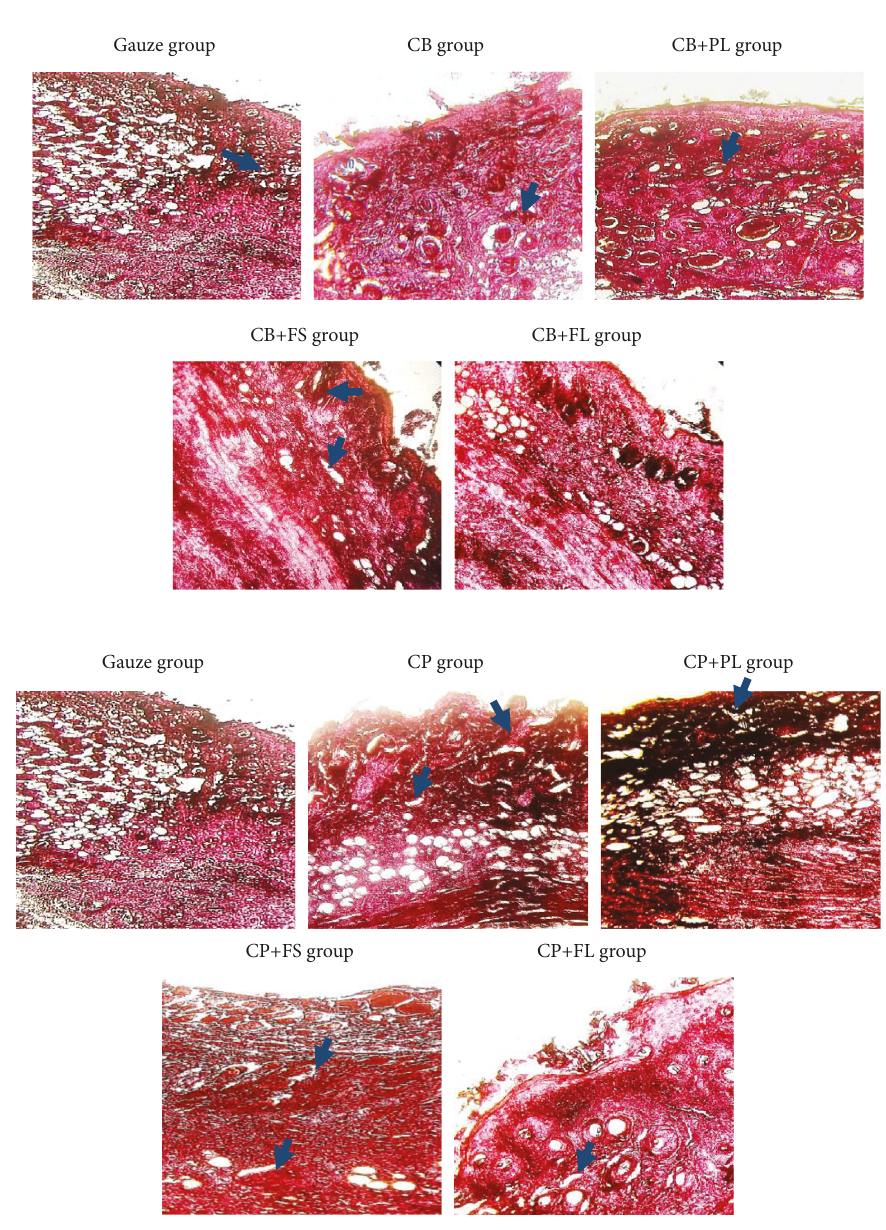
Figure 10: Light microscopy images of full-layer wounds (HE, X20) after 5 days. HE histological observation of wounds covered with vaseline gauze (VG) and current dressing CP, CP +PL, CP +FL, CP+FS, CB, CB+PL, CB+FS, CB +FL. Photomicrographs of histological sections stained in HE representative of the healing wound area in experimental BALB/ c mice on day 5. The gas group (control) shows oedema and fibrinoleukocytic exudate and fibrose. The CP alone, CP +PL, CP +FS, CB +FL, and CB+ FS groups show a cellular dermis, with fibroblast proliferation, depositing disorganized and misdirected collagen fibers. Capillary-sized blood vessels were visible (blue arrows). Scattered collections of inflammatory cells were observed in the CB only and CB +PL and CP+FL groups (